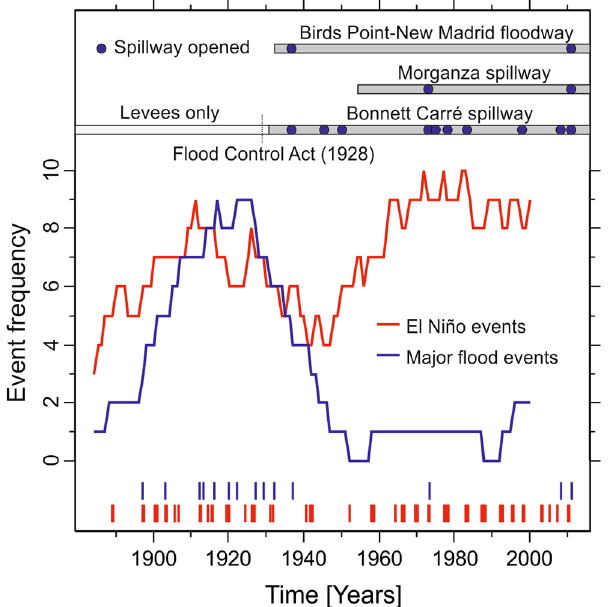
Figure 5. The frequency of historical El Niño events (red) and major Mississippi River floods at Vicksburg, Mississippi (blue) since the late 19 th century to present in relation to river engineering along the lower Mississippi River. Event frequencies calculated as the number of events within a moving 30-year